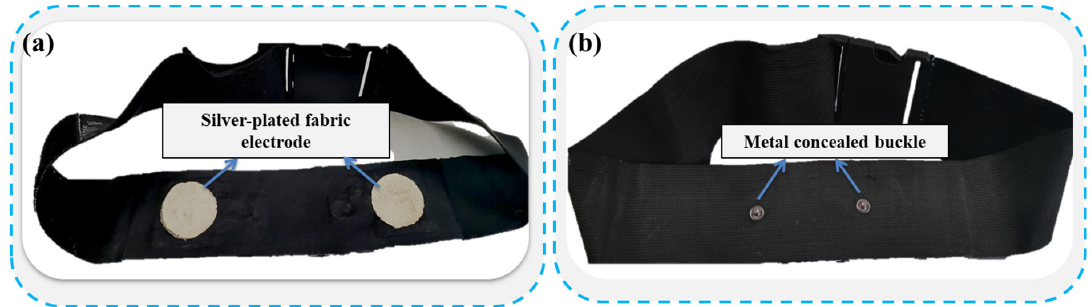
Figure 2. ( a ) ECG with the human body contact surface. ( b ) ECG belt outer